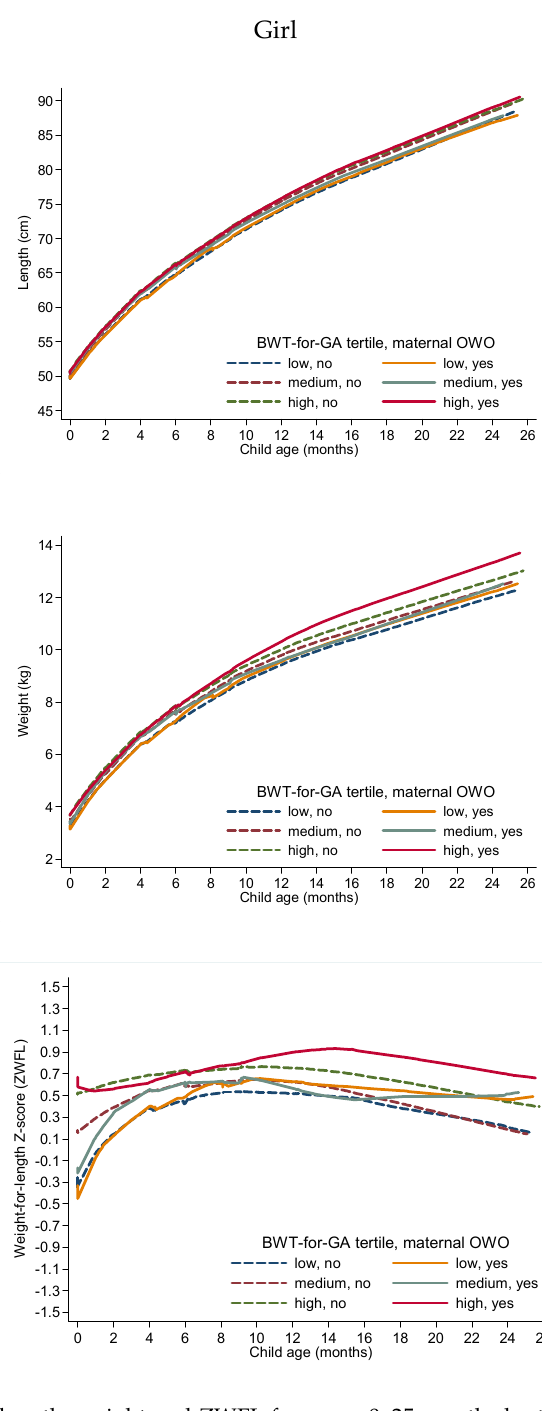
Figure 2. Lowess regression plot of length, weight and ZWFL from age 0–25 months by the sex- and gestational age-specific tertiles of birthweight and maternal prepregnancy OWO in 674 term-born AGA children (354 boys and 320 girls). OWO: overweight and obese; AGA: appropriate birth weight-for-gestational age; BWT for GA: birth weight-for-gestational age. 3. Results Of 806 term newborns, 12.4% were LGA, and 4.0% were SGA (Figure S1). This study focused on 674 AGA infants. The mean maternal age was 29.4 years (SD 3.5 years) at childbirth. Mean prepregnancy BMI was 21.2 kg/m 2 (SD 3.0 kg/m 2 ). The proportion of maternal prepregnancy overweight was 13.2%, obesity 3.1%, and underweight